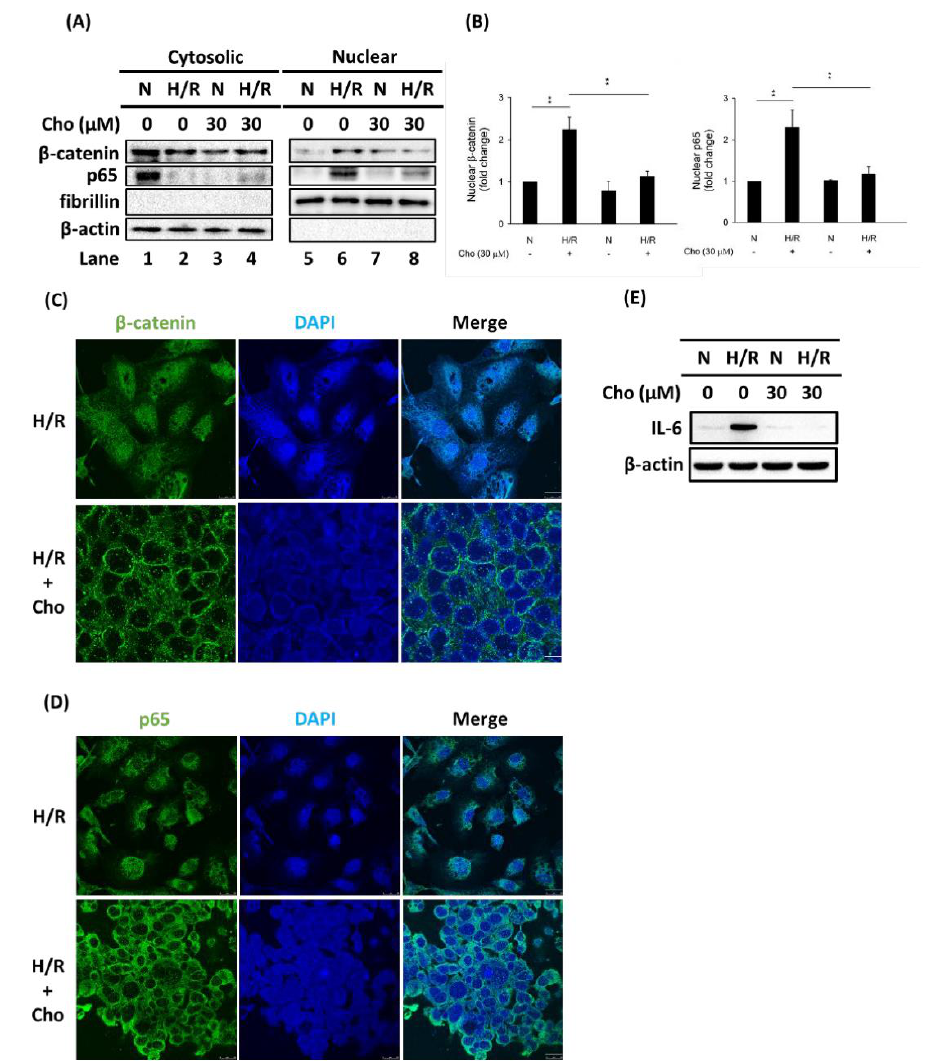
Figure 4. Chrysophanol reversed H/R-induced nuclear translocation of β-catenin and p65. ( A ) Cytosolic and nuclear fractions were isolated as described in “materials and methods”. Western blot analysis was performed to detect the subcellular localization of β-catenin and NF-κB using an antibody against the β-catenin and NF-κB subunit p65. β-actin was used as a cytosolic marker and fibrillarin as a nuclear marker. ( B ) The expression of β-catenin and nuclear p65 (nuclear p65) was quantified using ImageJ. All data are presented as the mean ± SD. ** p < 0.01. Immunofluorescence micrographs showed the distribution of β-catenin ( C ) and p65 ( D ). The β-catenin ( C ) and p65 ( D ) signal was intensely localized to the nucleus in HK-2 cells under H/R conditions (H/R) but was located in the cytoplasm under H/R conditions in the presence of 30 μM chrysophanol (H/R + Cho). The nuclei were counterstained with DAPI. Bar = 25 μm. ( E ) Chrysophanol alleviated the increasing in the IL-6 expression under H/R conditions. n = 3.